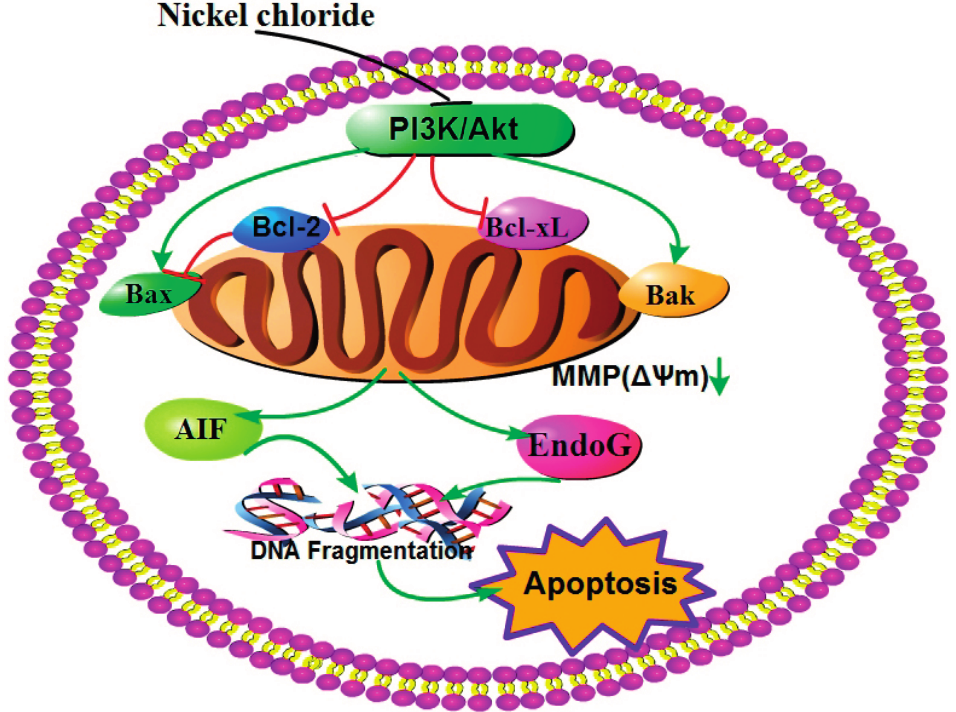
Figure 14. Schematic diagram of NiCl 2 -caused mitochondria-mediated